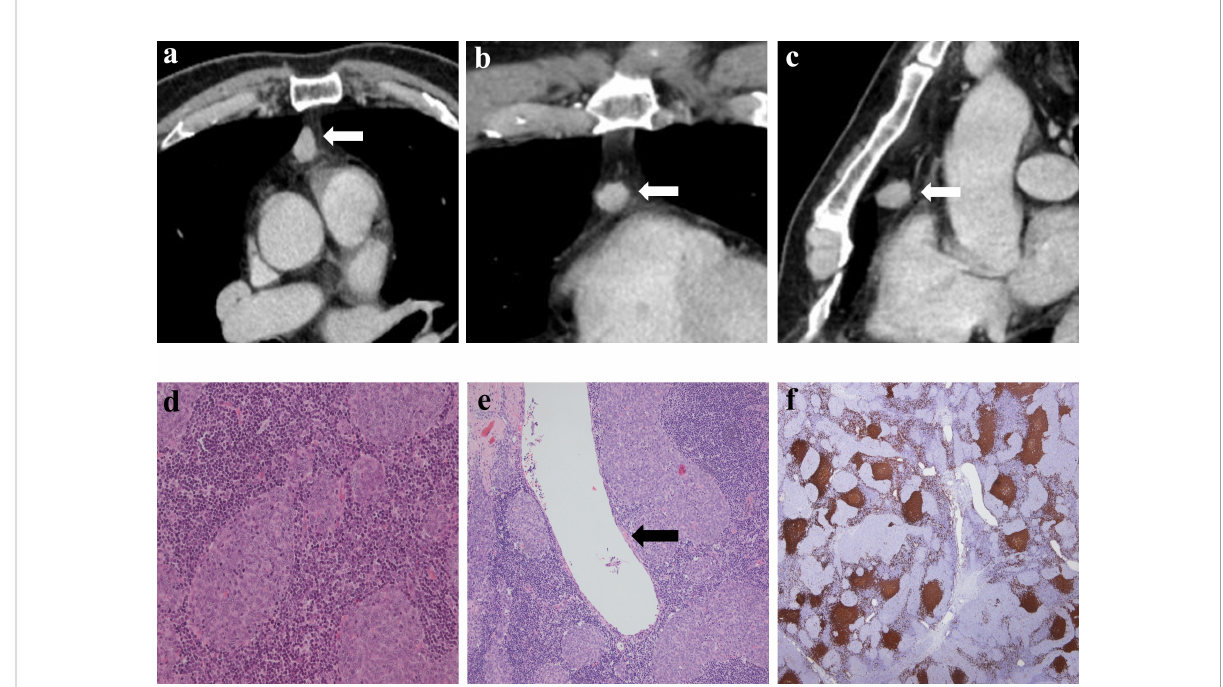
FIGURE 5 Imaging and histologic fi ndings in a 54-year-old man with primary mediastinal MTWLS (case 6). (A) Axial, (B) coronal and (C) sagittal chest CT images with contrast enhancement reveal a 1.4×1.3×1.6 cm solid and round or oval middle anterior mediastinal mass (white arrow) adjacent to the mediastinum pleura. The measurable solid components showed signi fi cant enhancement. (D) Hematoxylin-eosin (H-E) – stained section of the mass reveals spindle cells forming multiple micronodules separated by abundant interstitial lymphocytes. (E) Some cystic regions not found by CT were visible under the microscope, and cyst walls (black arrow) were covered with a single layer of epithelioid cells. (F) Lymphocytes had diffusely strong positive immunostaining for CD20 (= B cells), and the epithelial cell nests were negative for